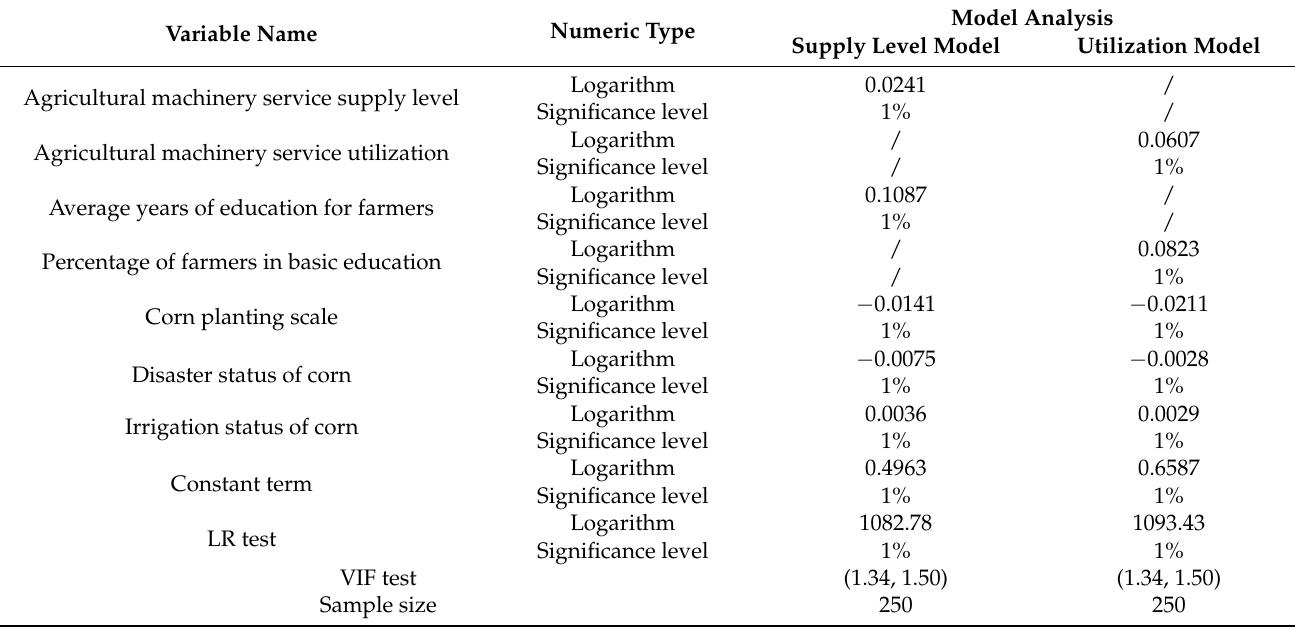
Table 8. Data analysis of corn